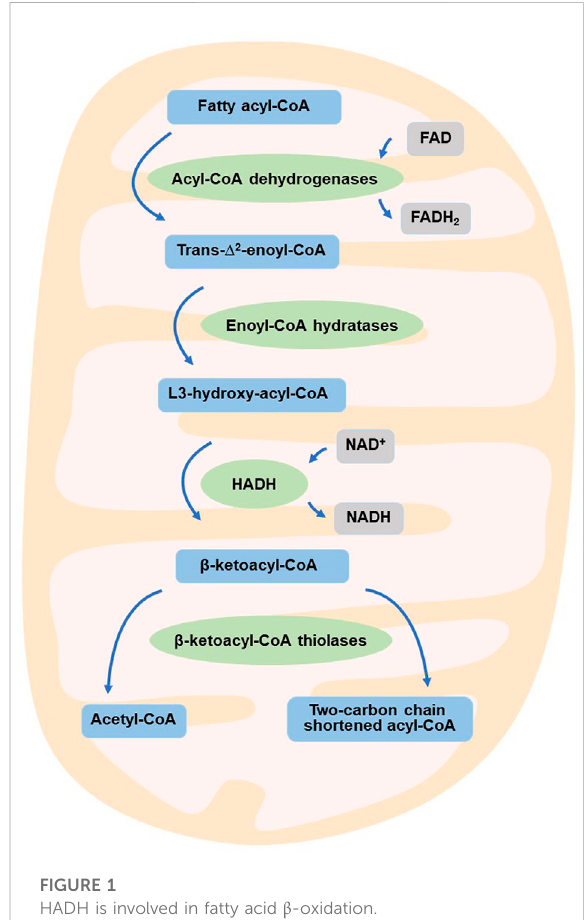
FIGURE 1 HADH is involved in fatty acid β